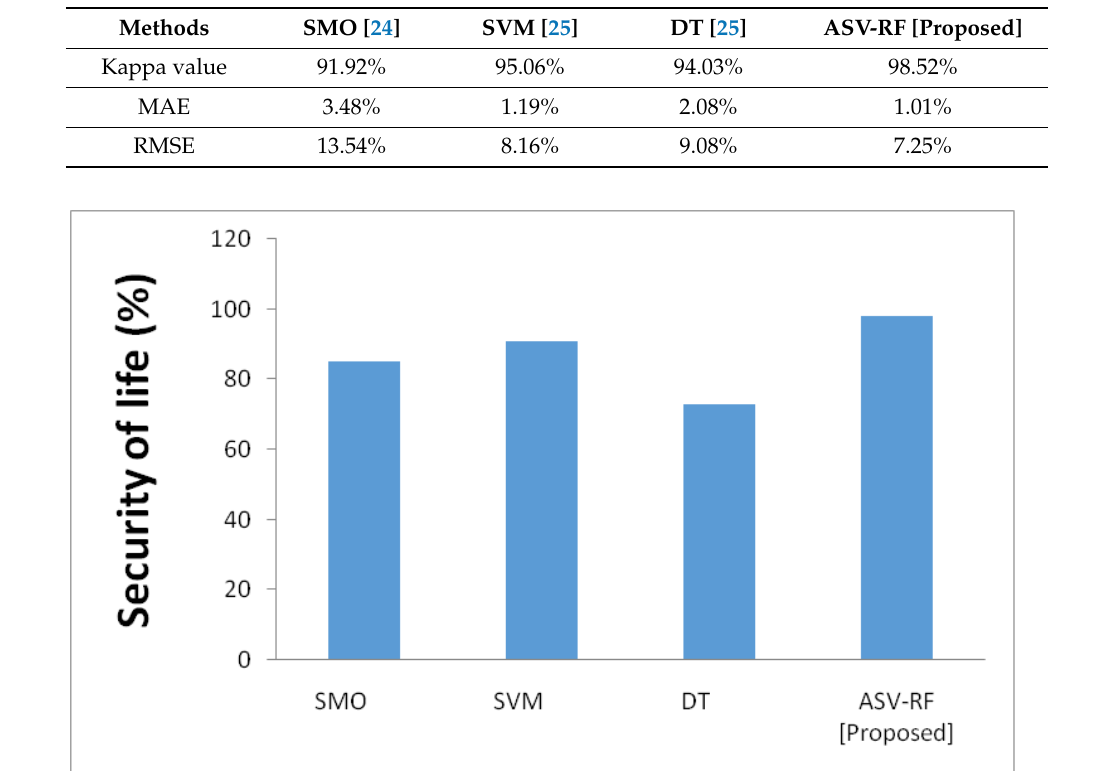
Figure 6. Results of Kappa ( a ), MAE, and RMSE metrics ( b ). Table 4. Results of Kappa, MAE, and RMSE metrics.